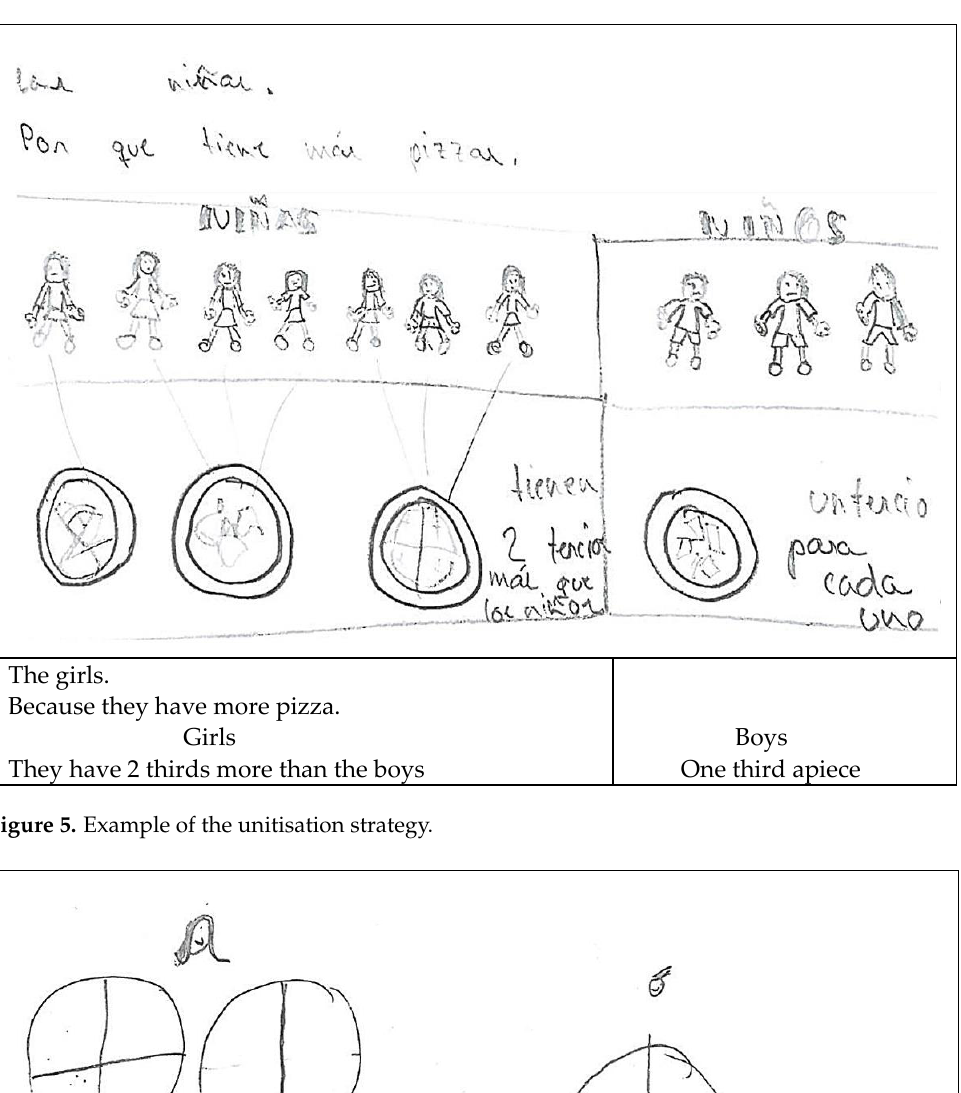
Figure 5. Example of the unitisation strategy.